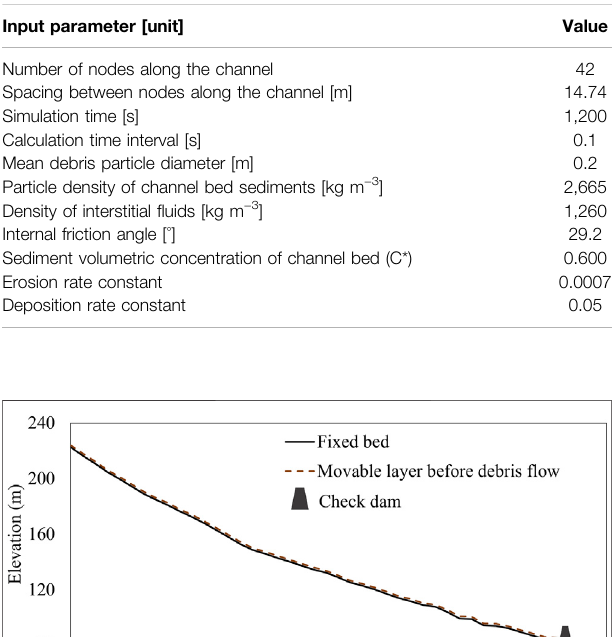
TABLE 1 | Summary of parameters and values used in Hyper Kanako.